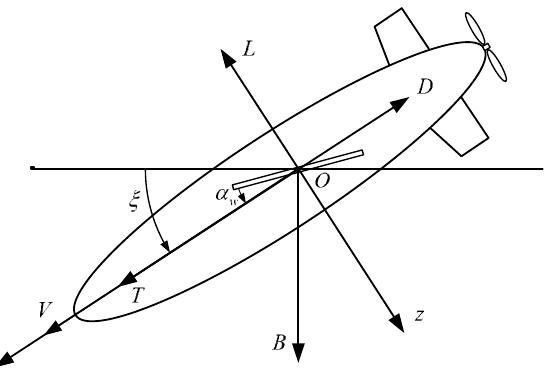
Figure 5. Force diagram of the glider diving at zero angle of attack in hybrid-driven mode.